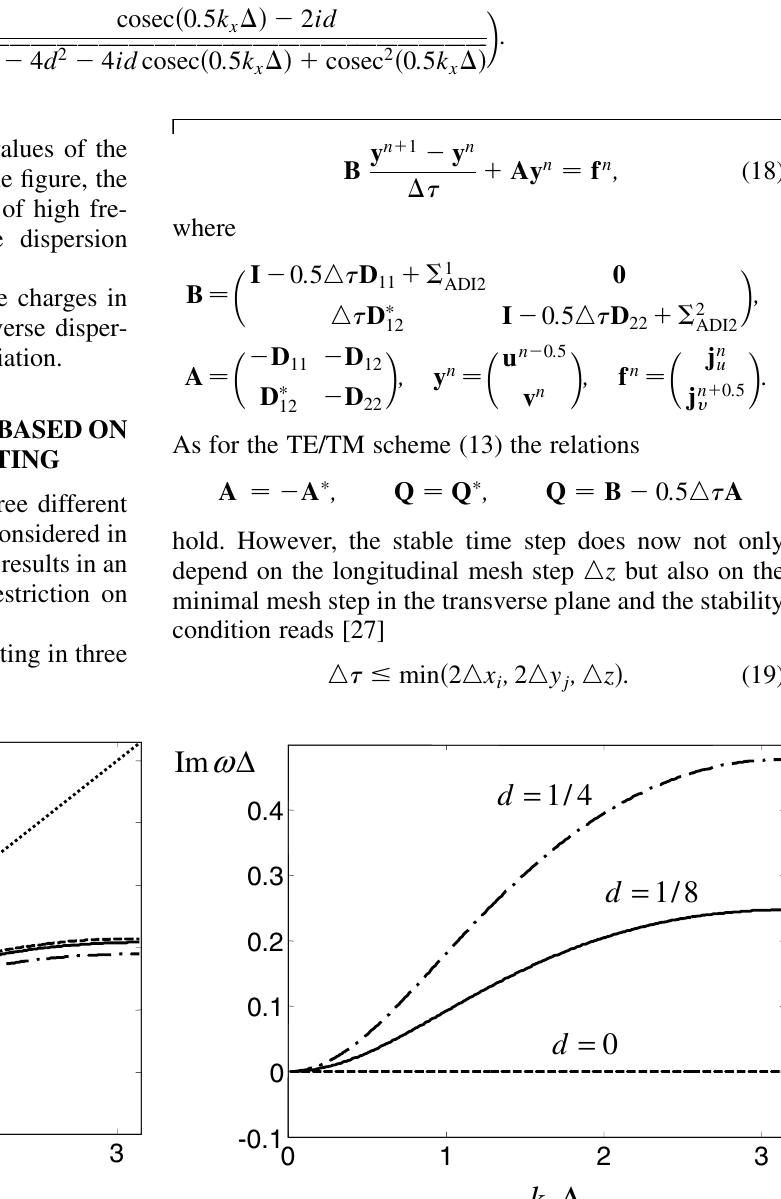
FIG. 3. Dispersion and damping in the transverse (cid:1) k d (cid:5) 0 (dashed curve), d (cid:5) 0 : 125 (solid curve), and d (cid:5) 0 : 25 (dot-dashed curve). The right-hand figure presents the damping for different values of the parameter d